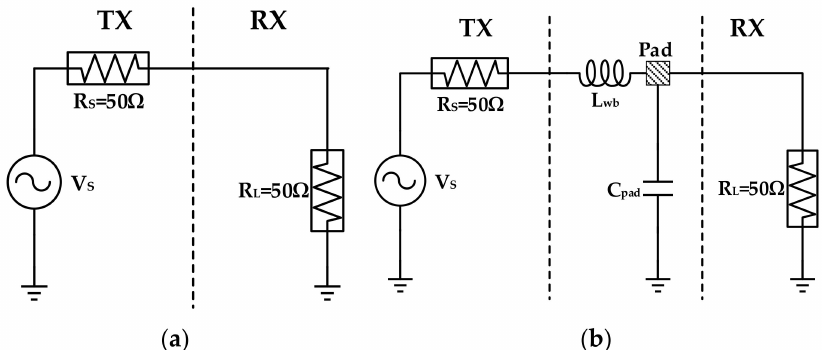
Figure 3. Input matching circuit ( a ) ideal and ( b ) non-ideal.